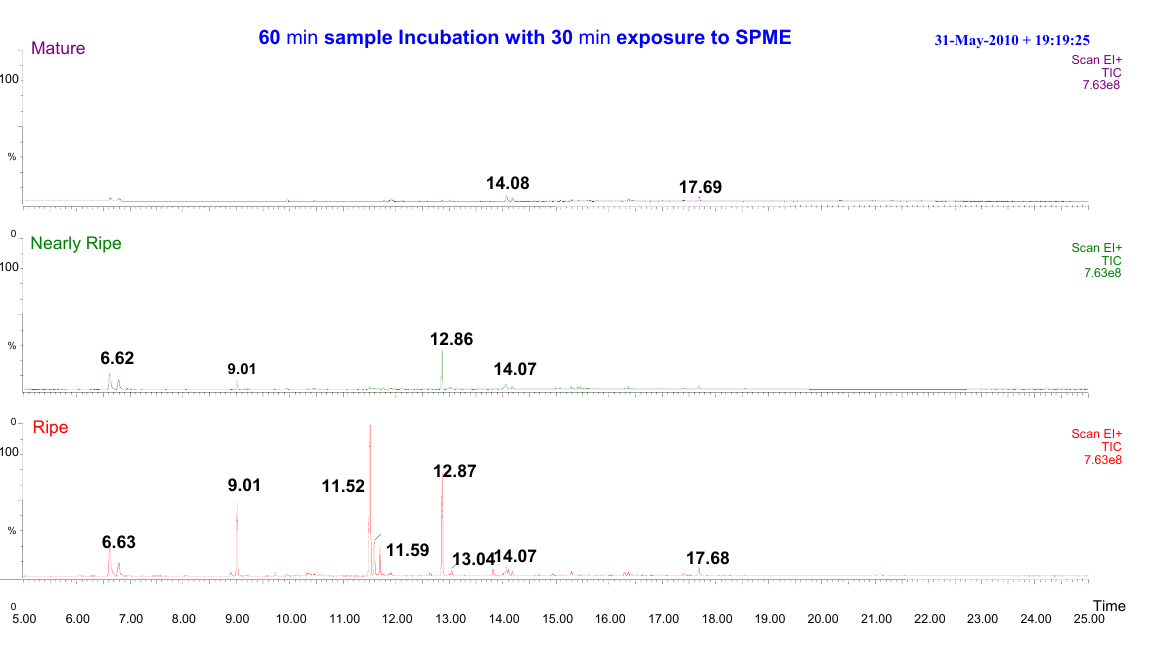
Figure 5. Three different maturity and ripeness levels of Harumanis mango headspace extraction using SPME.